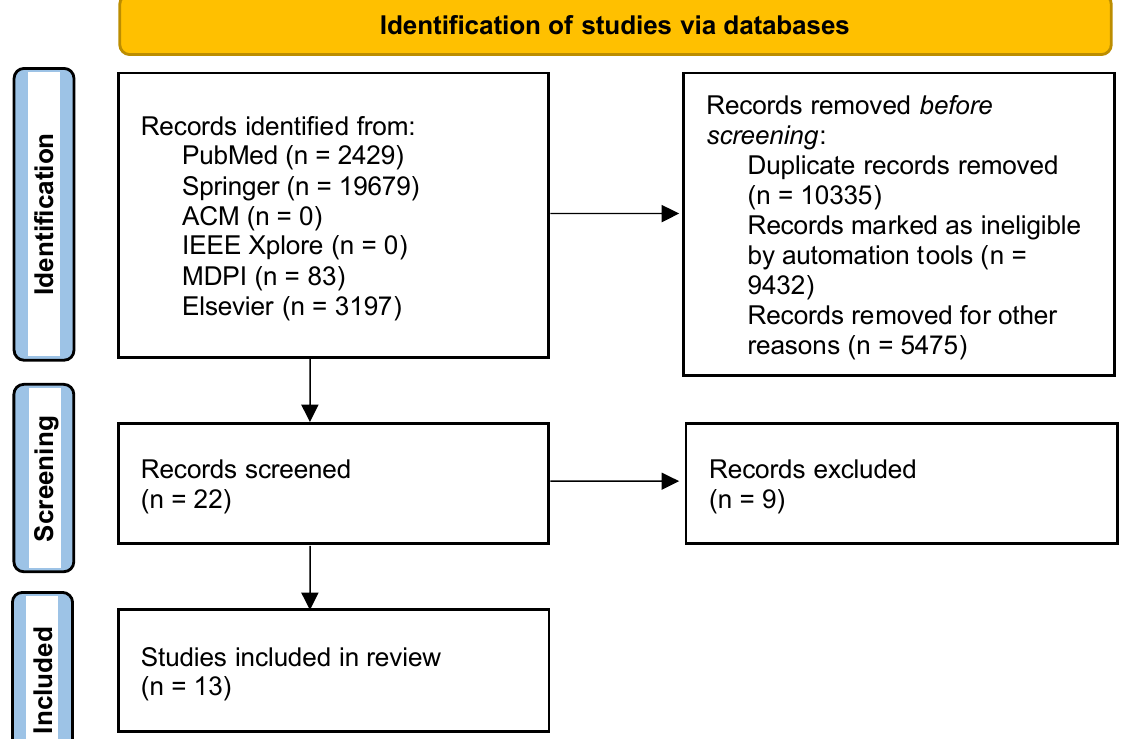
Figure 1. Flow diagram of the selection of the papers.